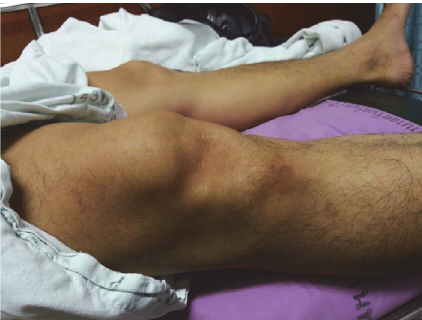
Figure 1: Clinical presentation with high-riding patella, anterior tilt of superior part of the patella, and skin dimple inferior to patella.